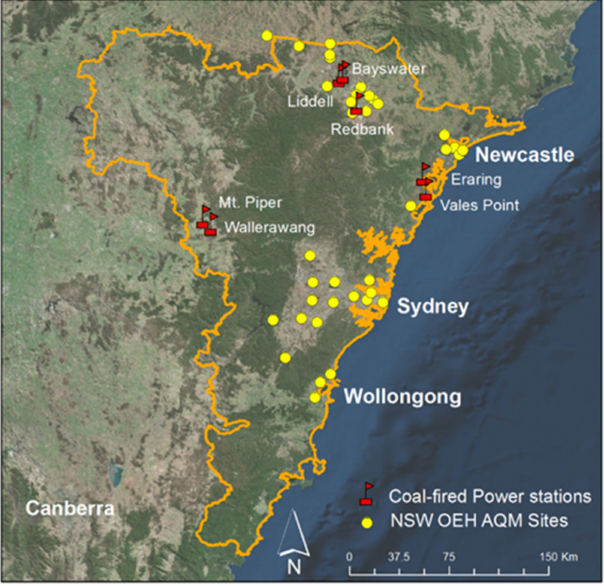
Figure 1. Location of air quality monitoring sites and coal-fired power stations in operation in